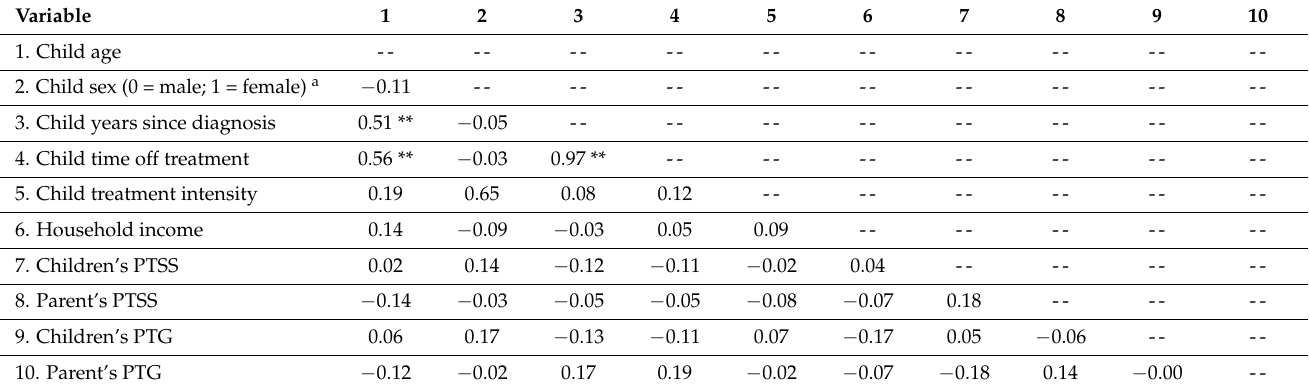
Table 2. Relationships between study variables.